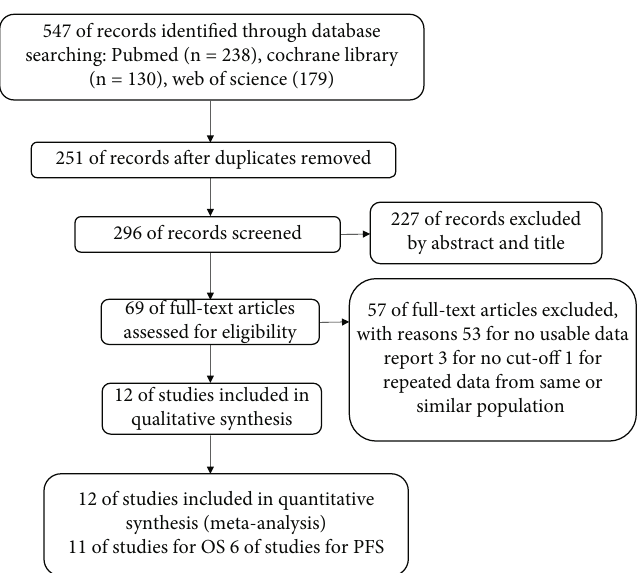
Figure 1: Flow chart of literature search and study